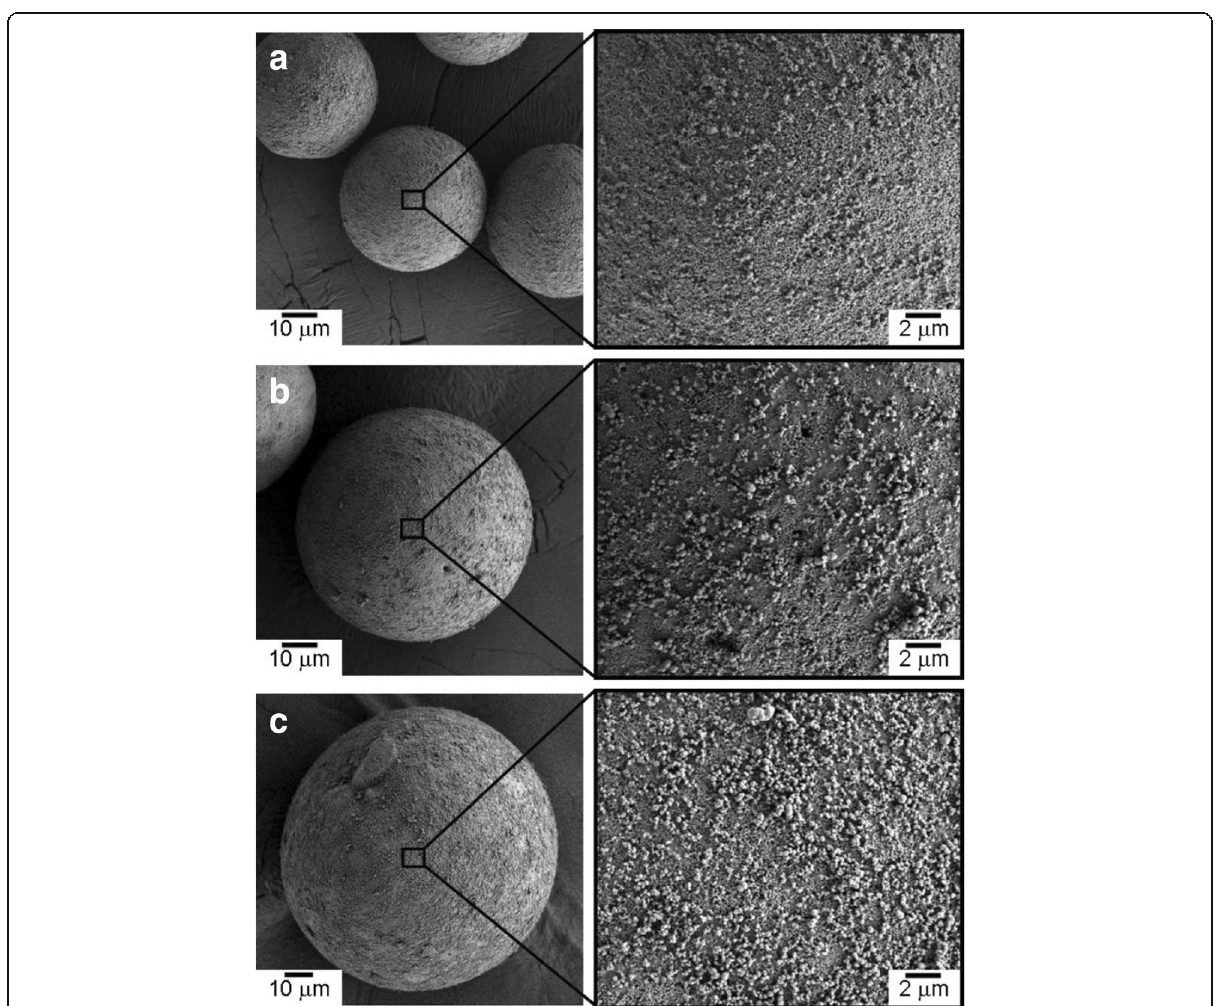
Fig. 3 SEM images of the 0.6 vol% CNP coated on Al 2 O 3 granulation particles with average diameter of a 37, b 62, and c 98 μ